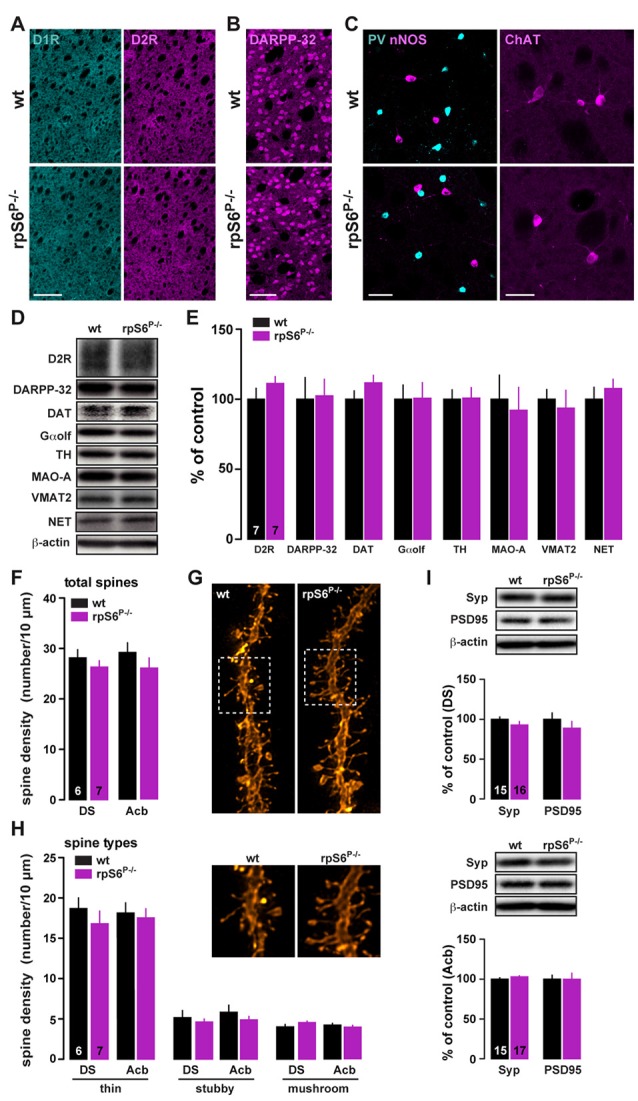
Striatal dendritic spines density and protein expression in rpS6P−/− mice. (A) Single immunostaining for D1R (cyan) and D2R (magenta) in coronal sections of the striatum from wt (top) and rpS6P−/− (bottom) mice. Scale bar: 250 μm. (B) Single immunostaining for DARPP-32 of the striatum from wt (top) and rpS6P−/− (bottom) mice. Scale bar: 60 μm. (C) Double immunostaining for nNOS (magenta) and parvalbumin (PV, cyan; left panel) or single immunofluorescence for choline acetyltransferase (ChAT; right panel) in the striatum of wt (top) and rpS6P−/− (bottom) mice. Scale bar: 40 μm and 20 μm. (D) Representative western blots and (E) quantified signals of D2R, DARPP-32, DAT, Gαolf, TH, MAO-A, VMAT2 and NET normalized to β-actin in whole striatal lysates from wt (black bars) and rpS6P−/− (magenta bars) mice. Results are represented as mean ± SEM (n and p values in Supplementary Table S1:2e). (F) Total number of spines per 10 μm in DS and Acb MSNs of wt (black bars) and rpS6P−/− (magenta bars) mice. (G) Representative dendrites spines visualized by fluorescent dye DiI. (H) Density of thin, stubby or mushroom dendritic spines were analyzed on a subset of dendrites in DS and Acb MSNs of wt (black bars) and rpS6P−/− (magenta bars) mice. The number of animals in each condition is indicated in the bars. Results are represented as mean ± SEM (n and p values in Supplementary Table S1:2g,h). (I) Representative western blots and quantified signals of Syp and PSD95 normalized to β-actin in DS (TOP) and Acb (bottom) lysates from wt (black bars) and rpS6P−/− (magenta bars) mice. Results are represented as mean ± SEM (n and p values in Supplementary Table S1:2i).